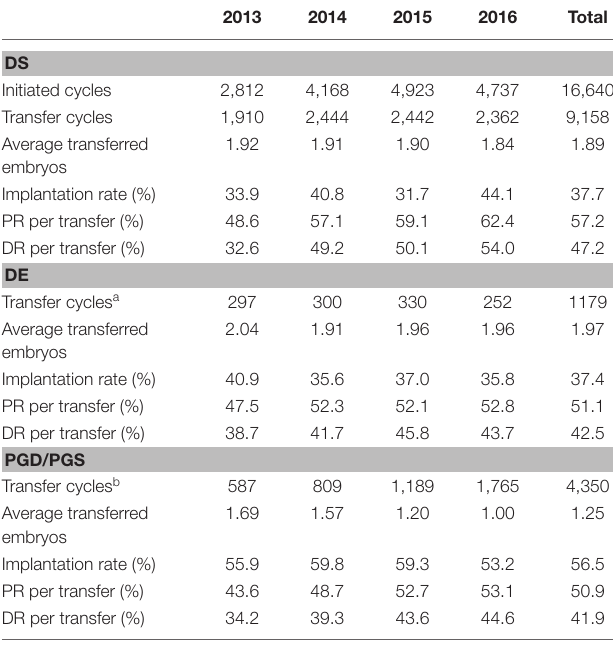
TABLE 3 | Results after PGD/PGS, DS, and DE in